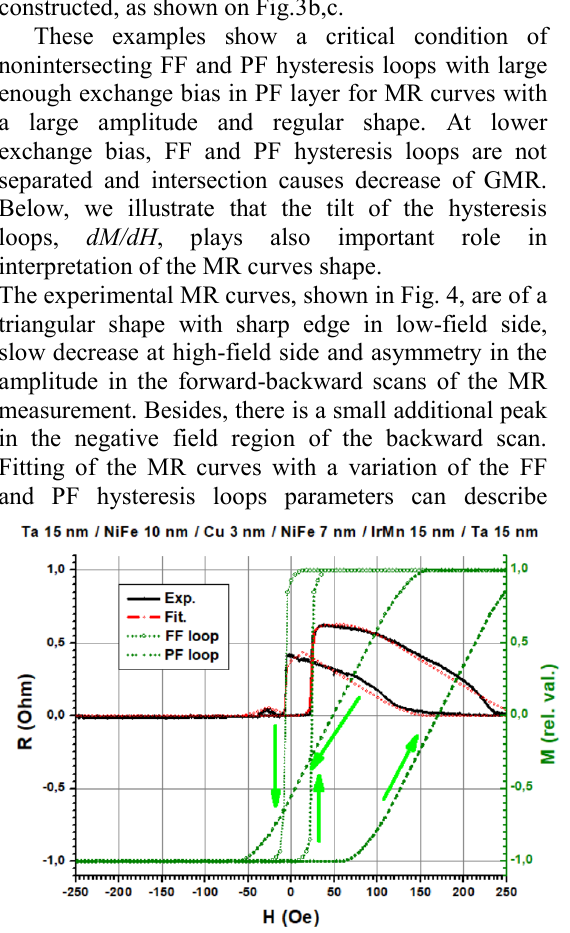
Fig.4 Experimental MR curves (black) with fitting (red) and derived FF and PF hysteresis loops (green). Small extra peak belongs to the MR curve, corresponding to decreasing external magnetic